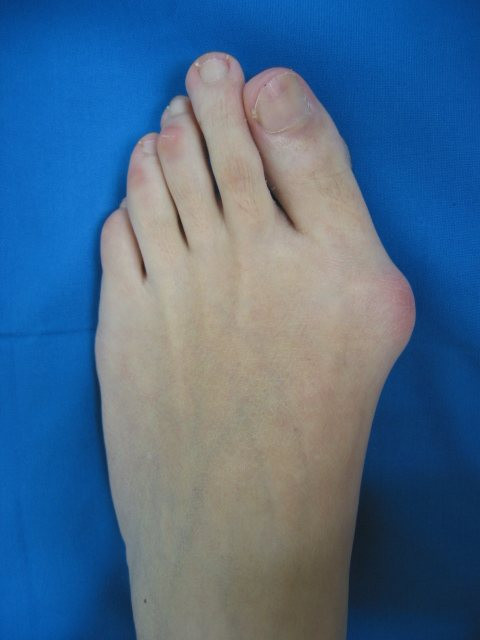
Representative image of hallux valgus deformity.